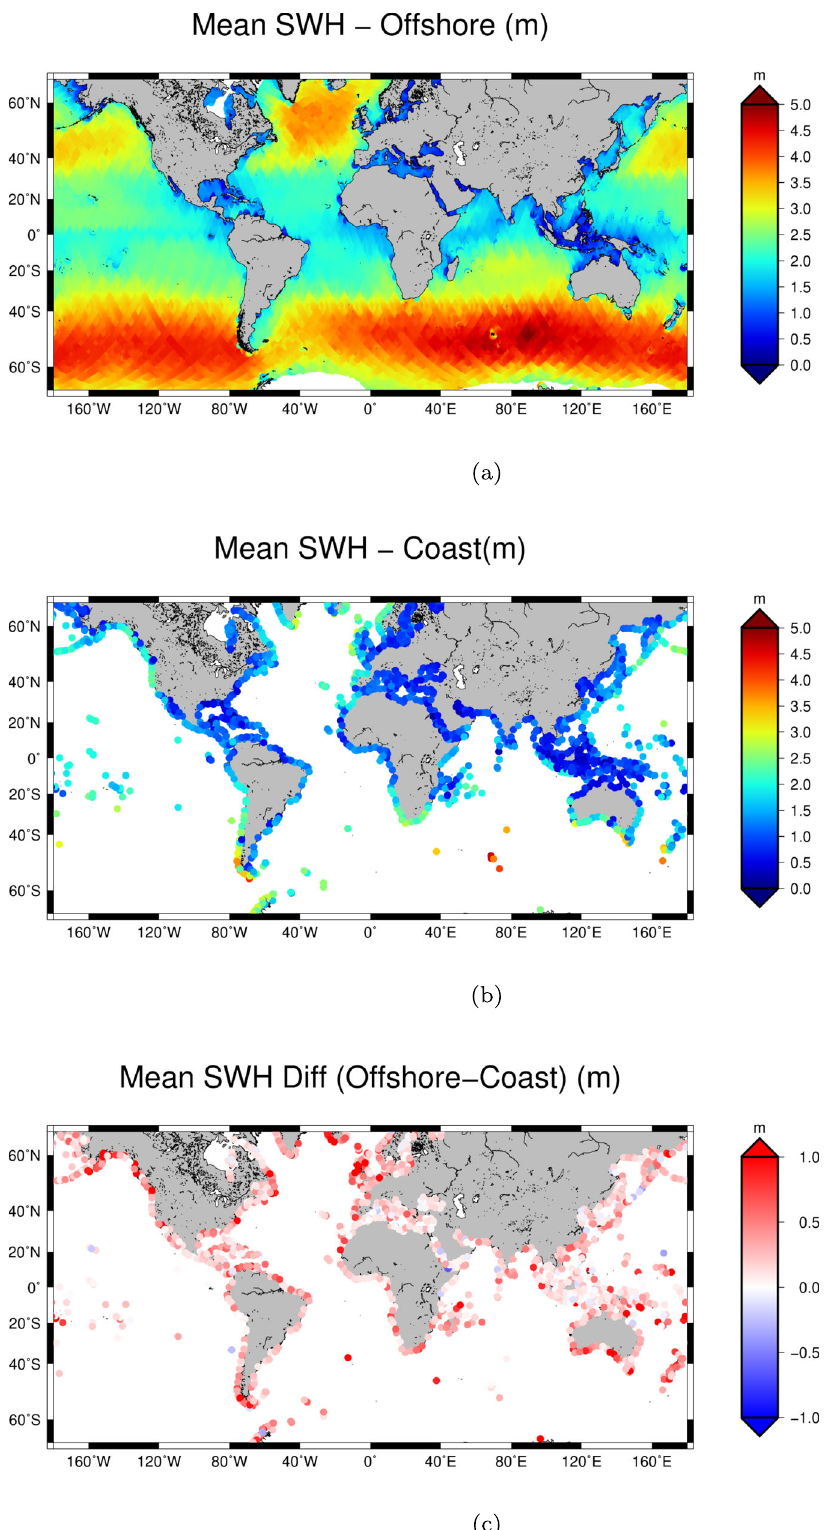
Fig. 1 Mean Signi fi cant Wave Height (SWH). Mean SWH from along-track satellite altimetry over the global ocean ( a ) and along the coastline ( b ). ( c ) shows the difference between the offshore and the coastal